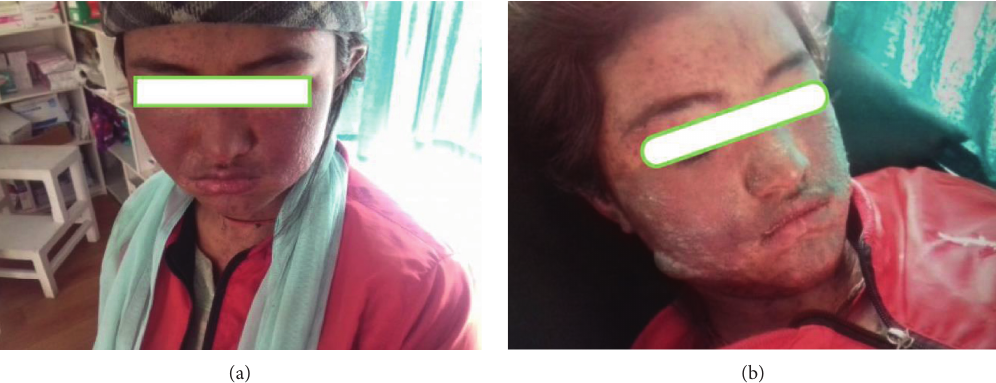
Figure 1: (a, b) Erythema and vesicobullous lesions involving the face and neck.